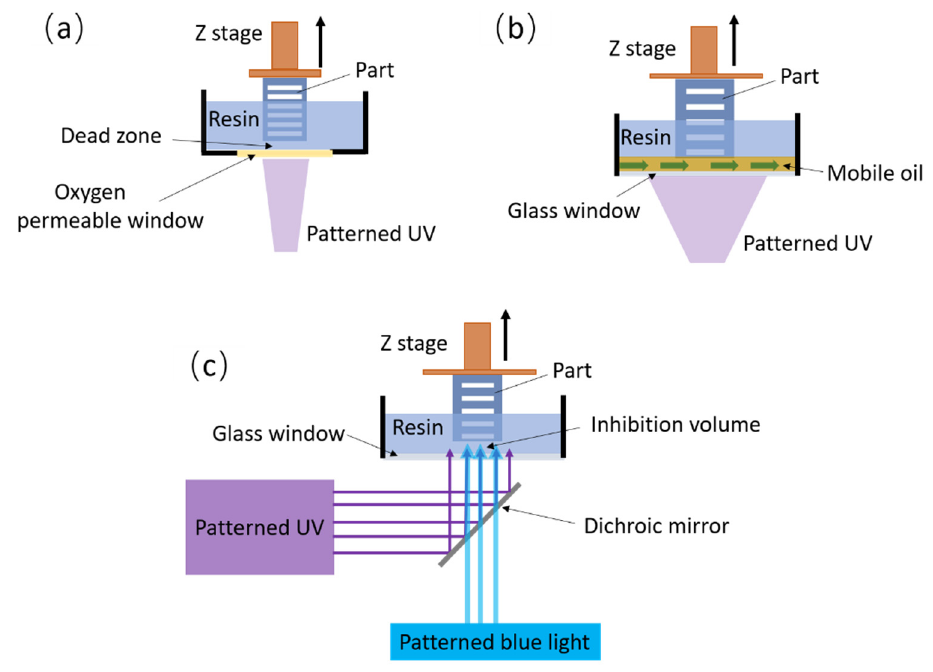
Figure 6. The continuous stereolithography processes. ( a ) Schematic diagram of the continuous liquid interface production (CLIP) process. ( b ) Schematic diagram of the high-area rapid printing (HARP) system. ( c ) The continuous stereolithography realized by using dual-wavelength irradiation.